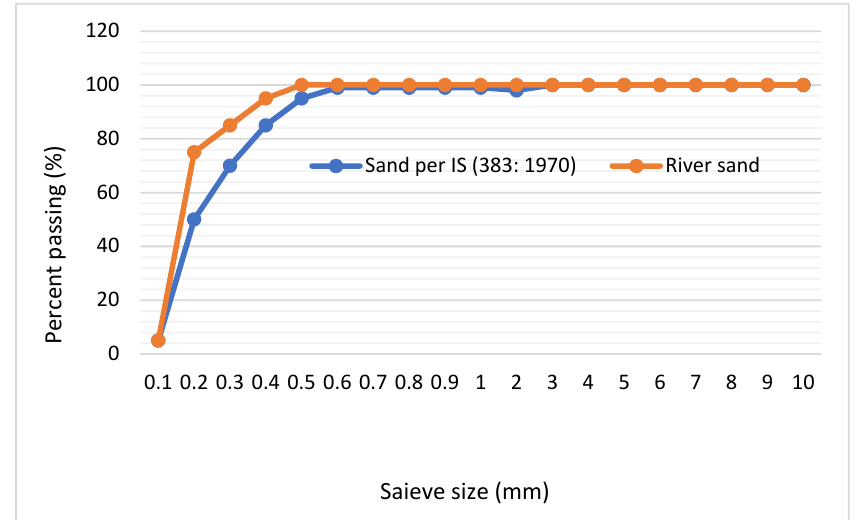
Figure 1. Grading curve for river sand.